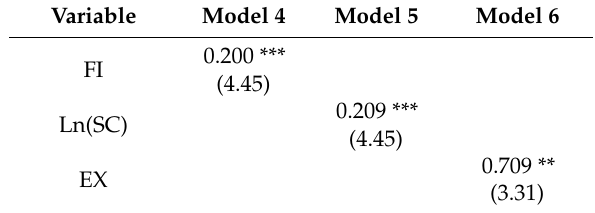
Table 6. The results of the spatial model including the interaction item at the provincial